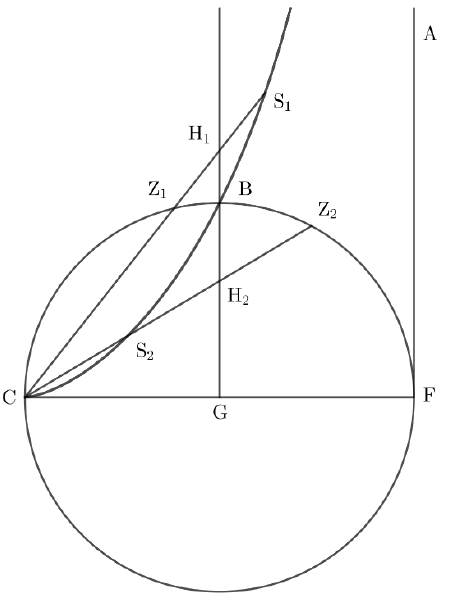
Figure 2. The construction related to Proposition 1 by Huygens on the cissoid.